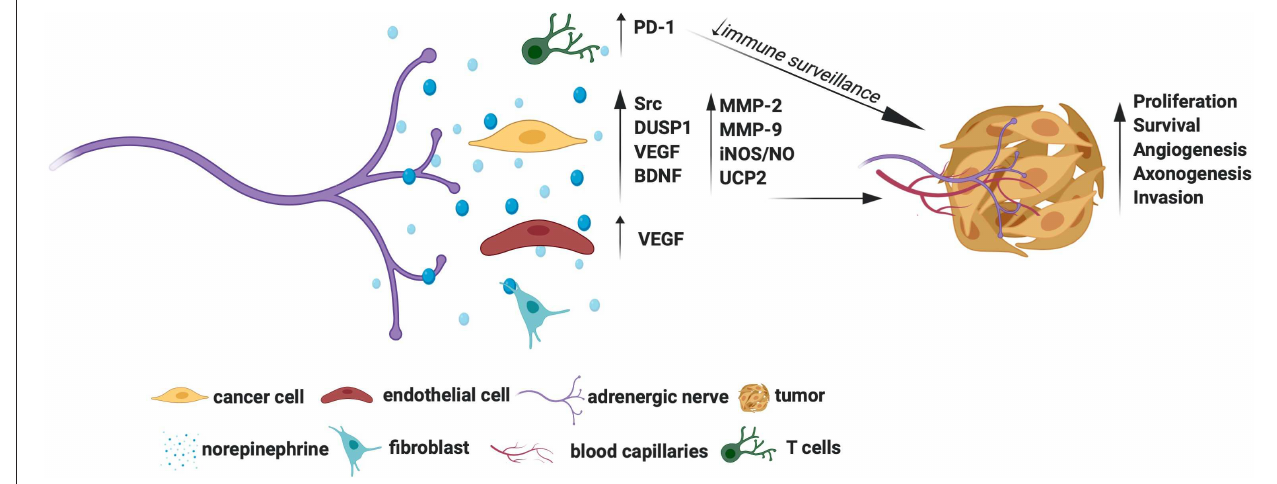
FIGURE 1 | Molecular mechanisms for the tumor promoting actions of adrenergic